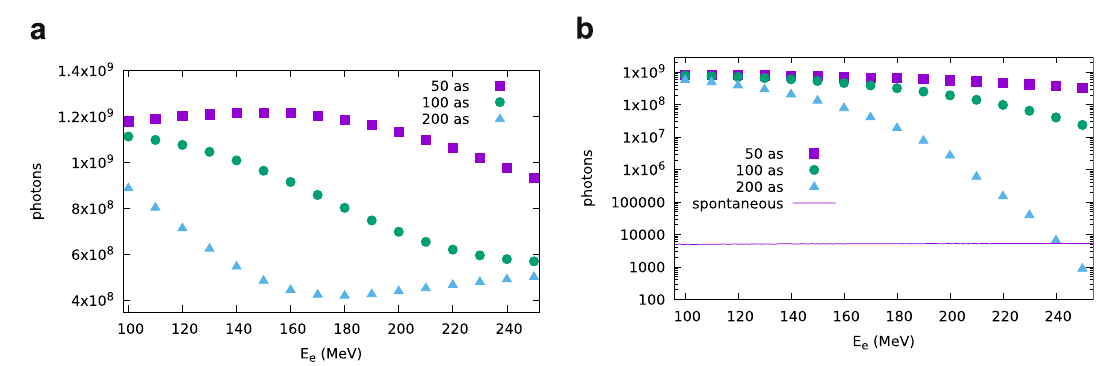
Figure 4. Flux of coherent undulator radiation obtained using SPECTRA for the parameters of Fig. 2 and electron beam charge of 0.1 pC. ( a ) Photons with energy E > 0.1 eV . ( b ) Photons with energy